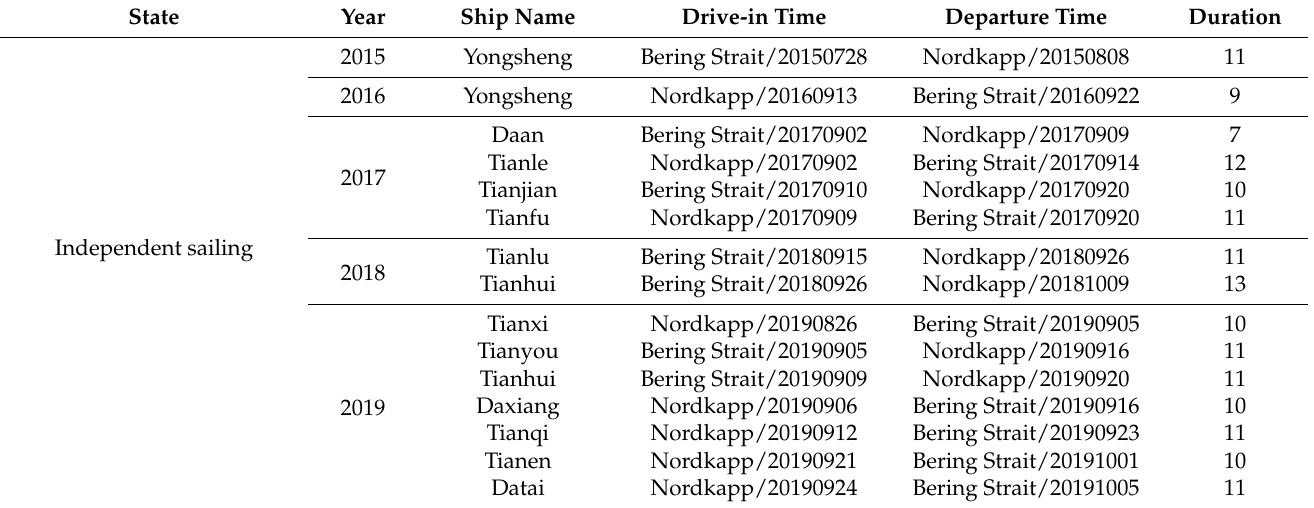
Table 2. Summary of independent sailing cargo ships from 2013 to